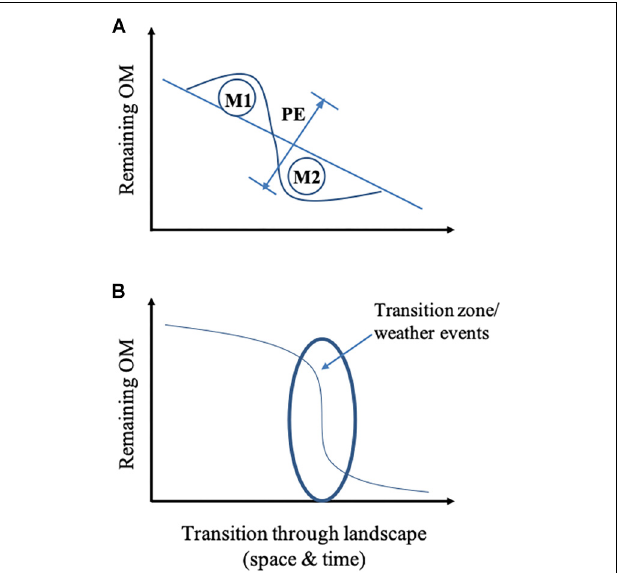
FIGURE 3 | Conceptual schematic of organic matter (OM) decomposition through the landscape at the substrate level including different mechanisms (A) , and temporal and spatial hotspots such as extreme weather and strong biogeochemical gradients along interfaces (B) . In panel (A) OM decomposition is depicted under constant environmental conditions (linear response). Different mechanisms (M1, M2) and factors (e.g., influx of material, stoichiometry, heterotrophic demand, electron availability, energy, redox changes, light etc.) have the potential to either increase or decrease OM decomposition rate. Thus, the priming effect (PE) can appear as either positive or negative. In the case where OM moves between different landscape compounds (aquatic/terrestrial), mechanisms and time scale determine OM fate and hence microbial transformation (B) . Environmental changes at transition zones and specific temporal events (e.g., thunderstorm, flooding) or anthropogenic impacts into account will affect the fate of OM, for example, sediment burial will greatly reduce OM